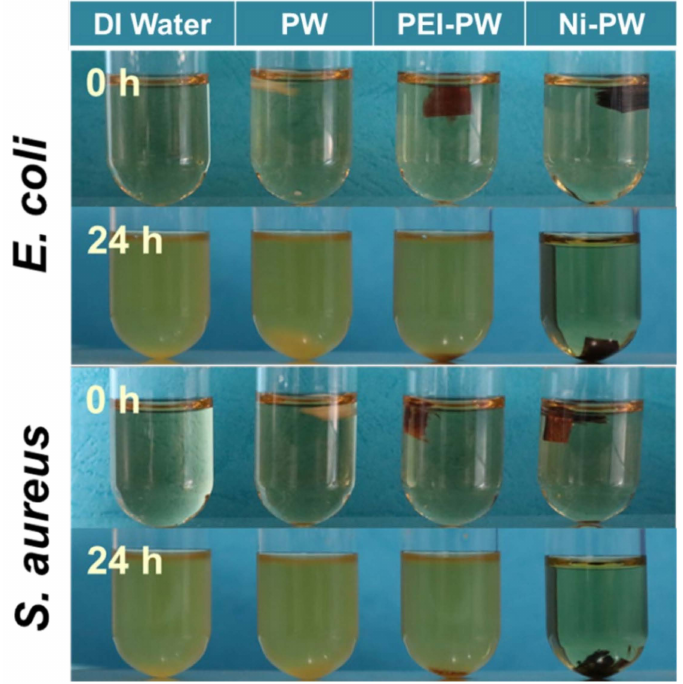
Figure 4. Digital images of LB liquid medium turbidity assays at the beginning, 0 h, and after 24 h of incubation. E. coli and S. aureus in LB liquid mediums containing the quality of deionized water (control), PW, PEI-PW, and Ni-PW were studied, respectively.